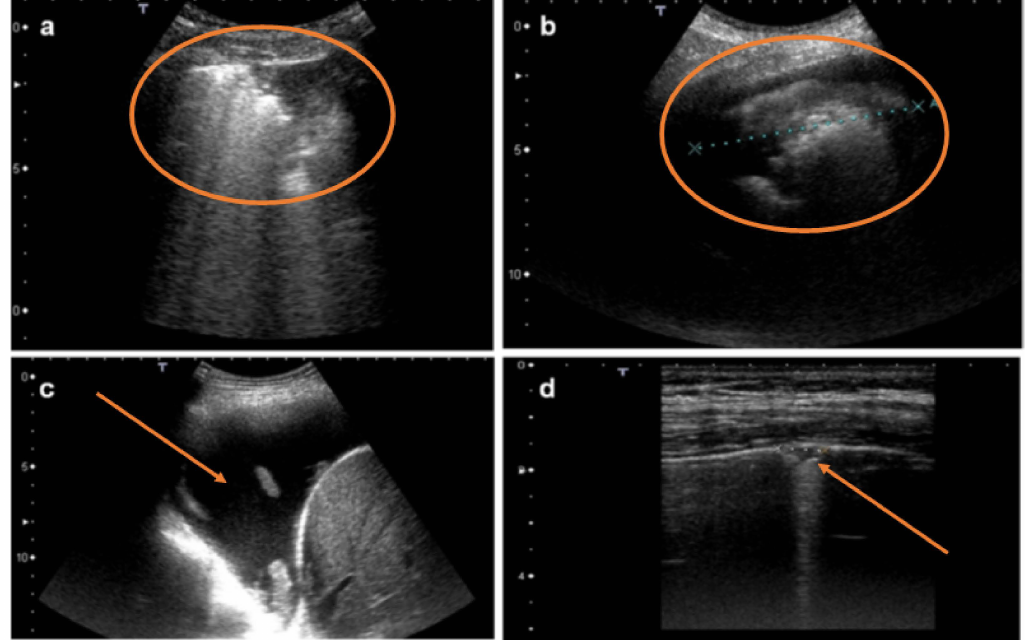
Figure 5. Image ( a ) shows lung consolidation with associated artifacts in a red circle (pneumonia). Image ( b ) shows lung consolidation with associated pleural effusion (lung cancer in red circle). The red arrow in image ( c ) shows a large finely corpuscular pleural effusion (mesothelioma). The red arrow in image ( d ) shows a single nodule emerging on the pleural surface with a regular pleural